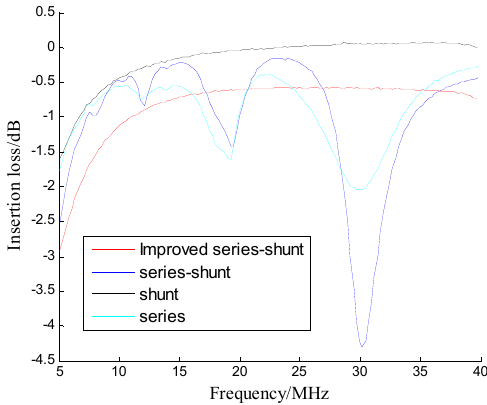
Figure 14. Insertion loss performance of conventional and improved switches.